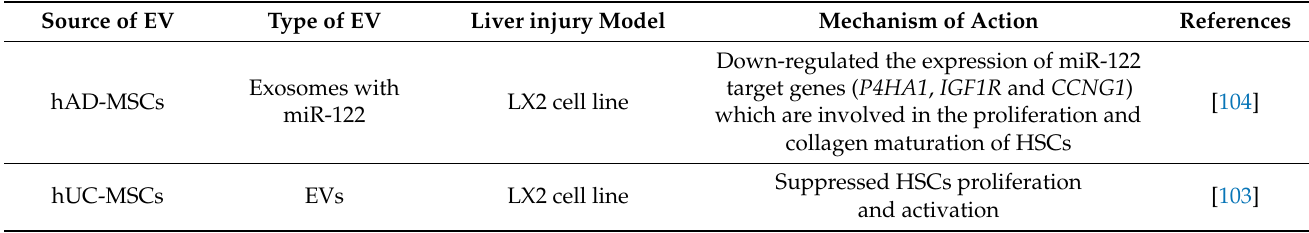
Table 1. Effects of extracellular vesicles from mesenchymal stem cells (MSC-EVs) in chronic liver injury models in vitro and in